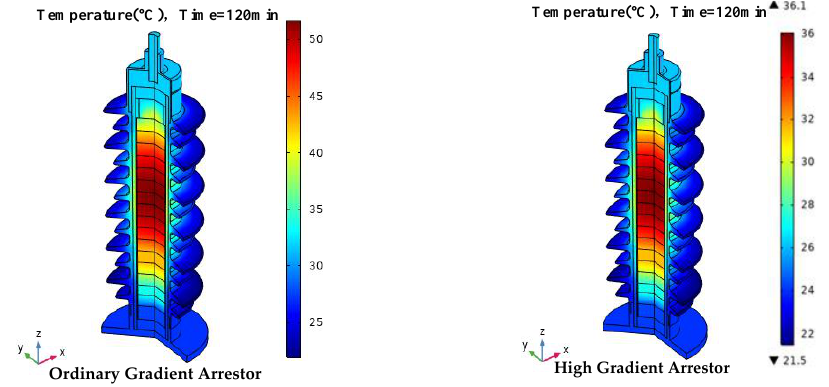
Figure 11. The maximum temperature of ordinary-gradient and high-gradient valve under power frequency condition.